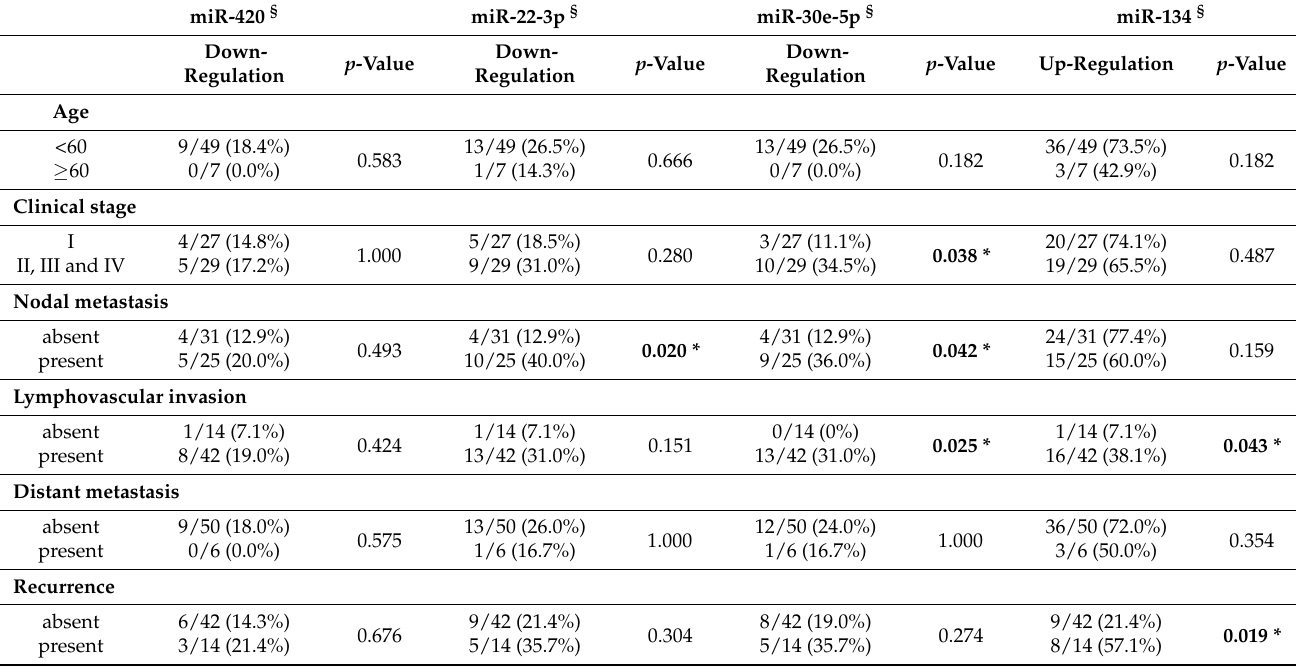
Table 3. Correlation between clinicopathologic factors and miRNA